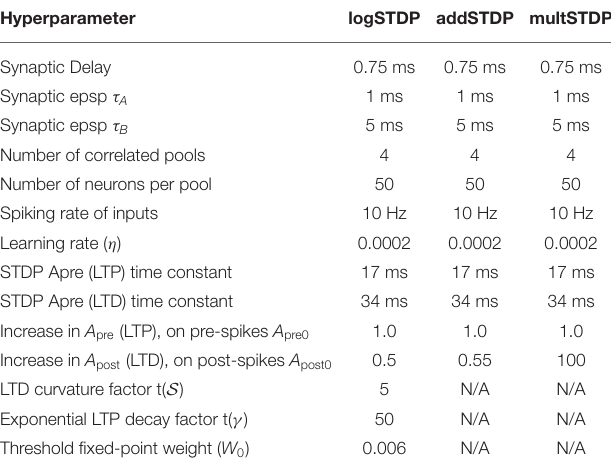
TABLE 1 | Table showing the set of hyperparameters for various STDP processes.